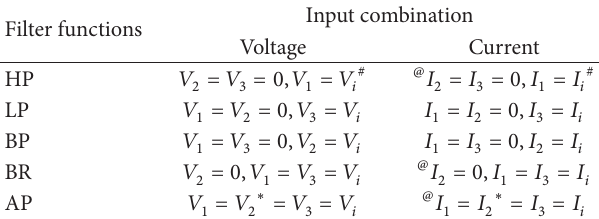
Table 2: Derived filter functions for various input combinations.